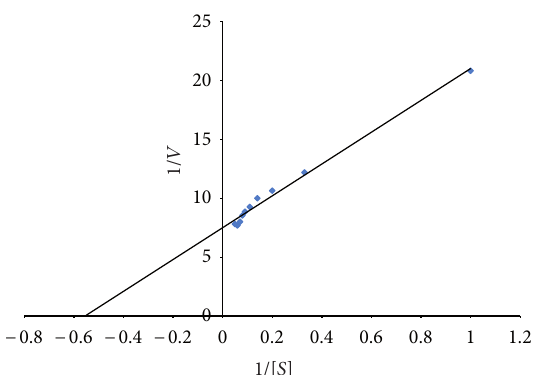
F 2: Lineweaver-Burk plot for the determination of Km and